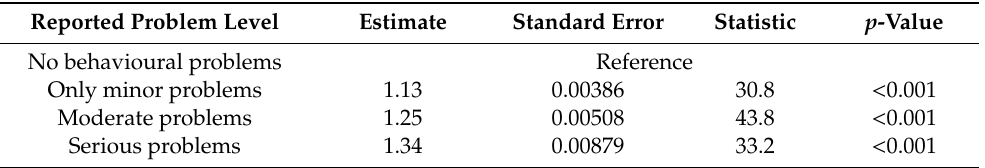
Table 2. The probability of three levels of undesirable behaviours being reported, when compared to no behavioural problems, in the self-reported categories on the ridden horse questionnaire. The more undesirable or dangerous the behaviours reported were, the higher the value scored for the horse.